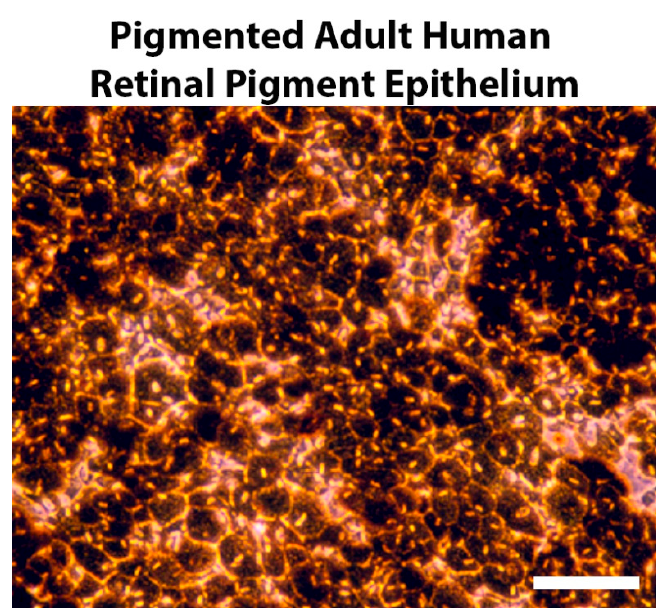
Figure 1. One of the many prominent features of the retinal pigment epithelium (RPE) is the production and accumulation of melanin granules. Representative phase-contrast micrograph of the cell morphology of human RPE cells from a 78-year-old healthy female donor. The primary cells were cultured with Dulbecco’s Modified Eagle Medium (DMEM) + 5% FBS. Total magnification 200×, scale bar = 25µm.